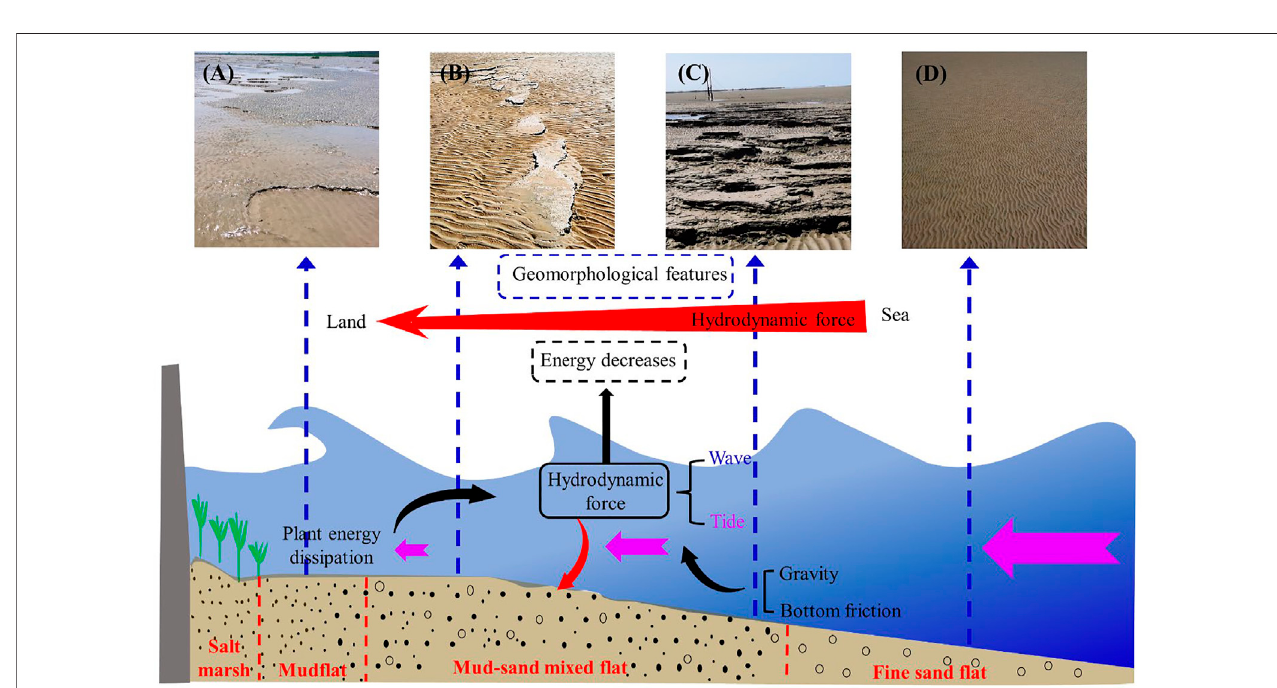
FIGURE 12 | Conceptual model of hummocky patches distribution mechanism. The hydrodynamic forces in the tidal fl at are mainly tidal currents (pink arrow) and waves. The attenuation of hydrodynamic forces propagating ashore is represented by changes in the size of the tidal current arrow and the shape of the water surface wave.Thehydrodynamic forces (redarrow)actonthe fl atsurfaceand cause thezonationofthetidal fl at(redfont). (A – D) represent thegeomorphologicalfeatures ofthe hummocky patches distributed from land to sea in the tidal fl at.